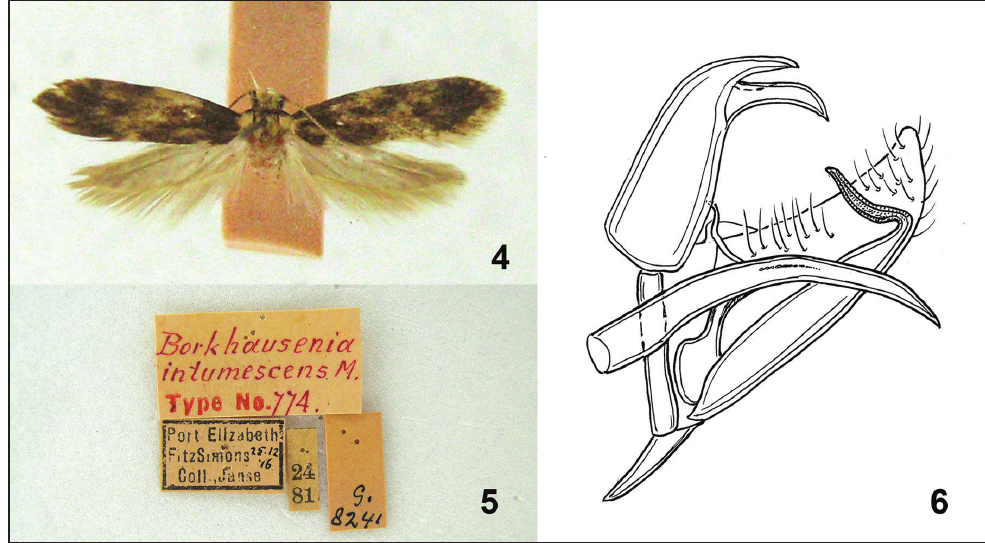
Figures 4–6. Borkhausenia intumescens Meyrick, 1921, South Africa, Port Elizabeth. 4. Lectotype male (DNMNH); 5. Labels of lectotype; 6. Male genitalia of lectotype (left valva omitted), A. Lvovsky del .